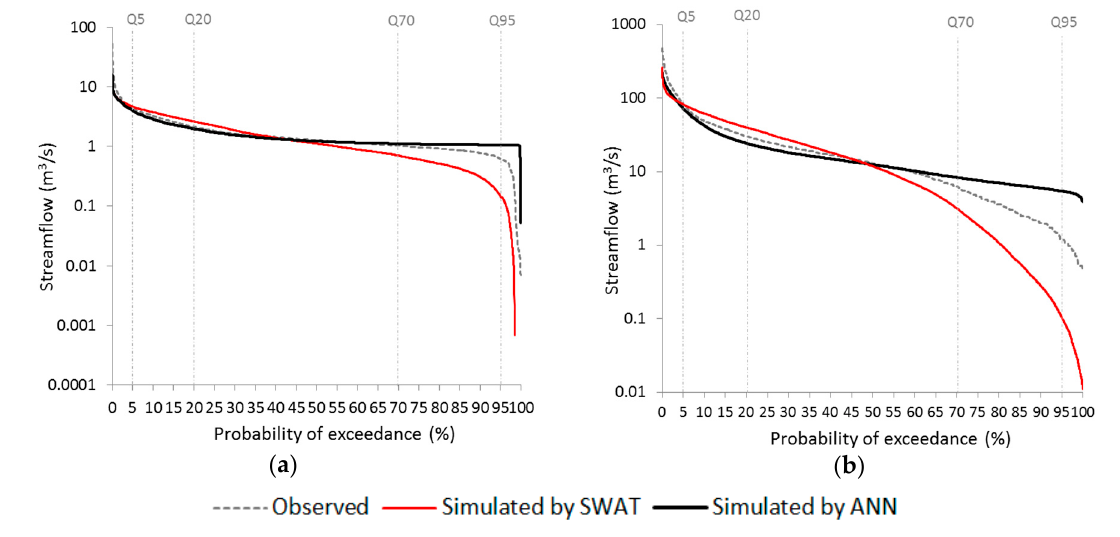
Figure 6. FDC of validation period of ( a ) LRB; ( b ) HSRB.